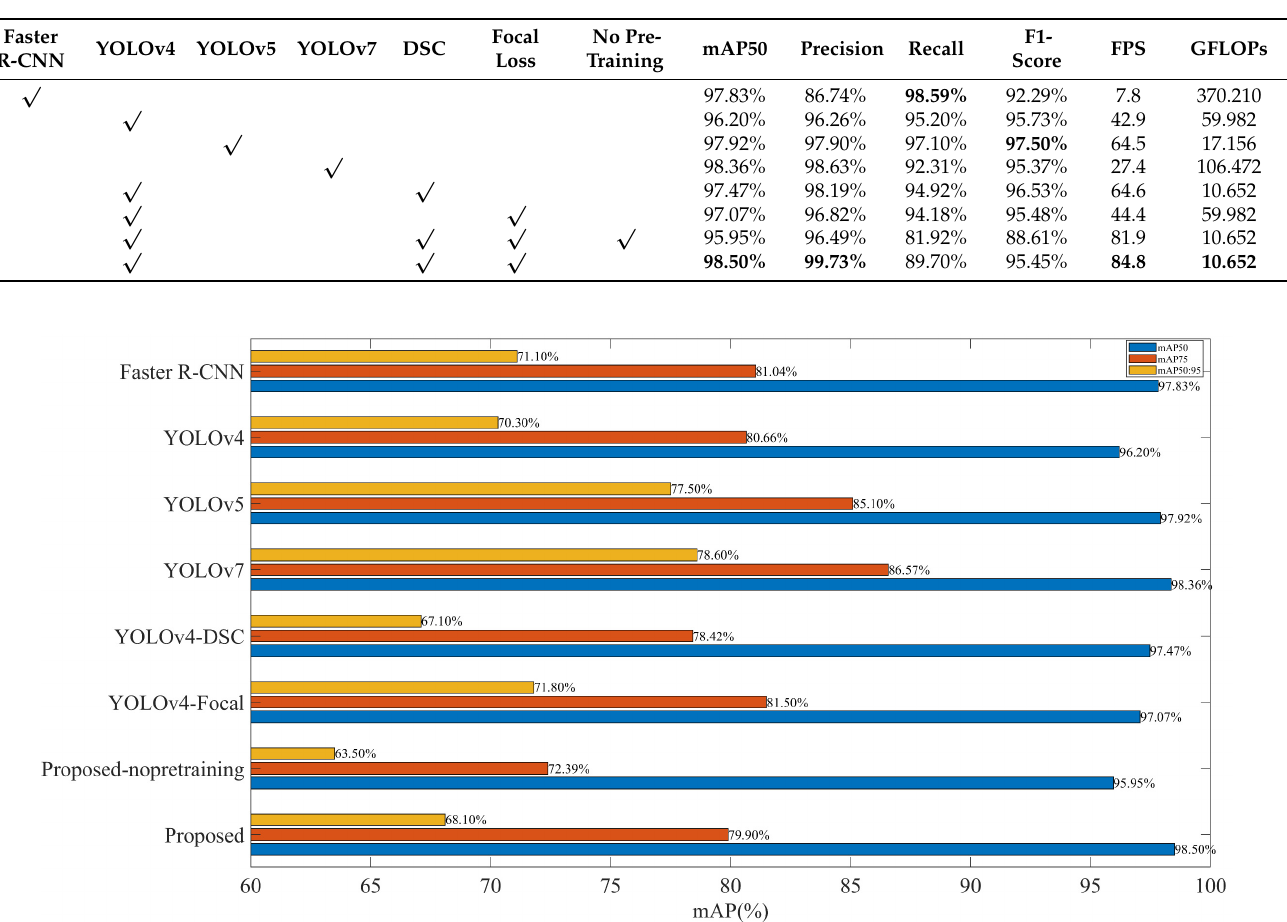
Table 3. Experimental results of different algorithms.